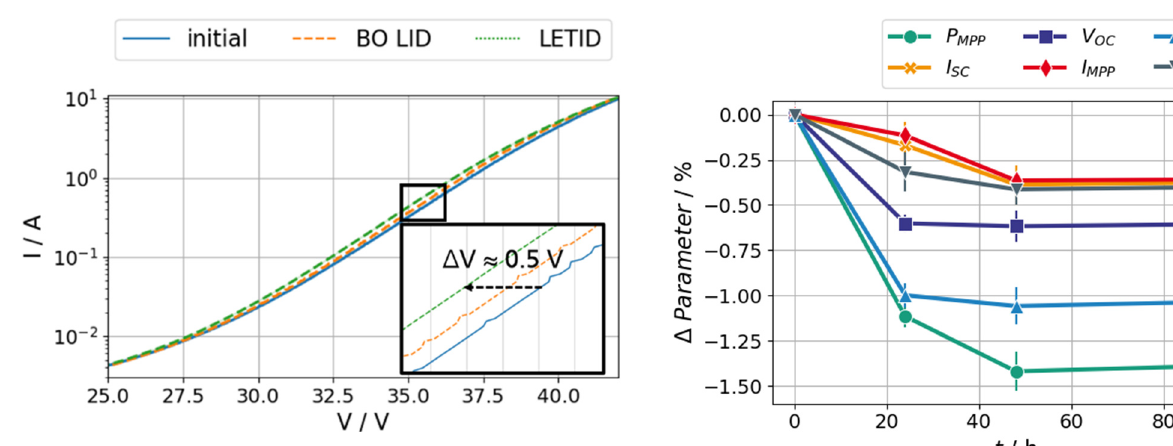
Fig. 4. Temperature corrected dark IV curves of module M04 before the experiment, after BO preconditioning and after LETID testing, shown for V ≥ 25 V.